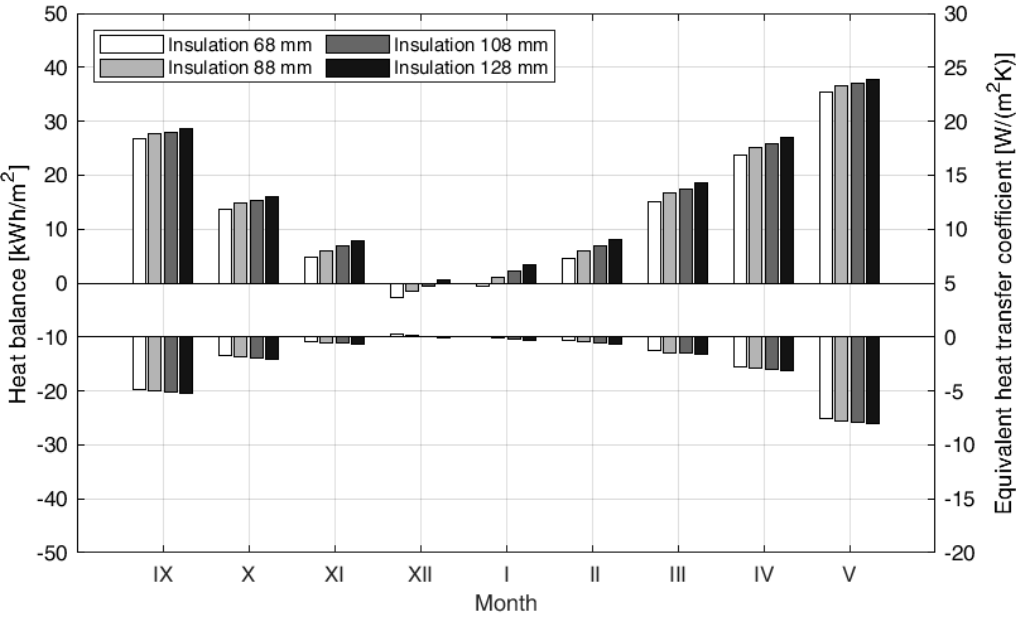
Figure 9. The Q m (upper graph) and U eq (bottom graph) values of the solar wall with transparent Figure 9. The (cid:1843) (cid:3040) (upper graph) and (cid:1847) (cid:3032)(cid:3044) (bottom graph) values of the solar wall with transparent Figure 9. The (cid:1843) (cid:3040) (upper graph) and (cid:1847) (cid:3032)(cid:3044) (bottom graph) values of the solar wall with transparent insulation (SW-TI) for a south orientation in the case of the application of insulation of di ff erent insulation (SW-TI) for a south orientation in the case of the application of insulation of different insulation (SW-TI) for a south orientation in the case of the application of insulation of different thicknesses (location in thicknesses (location in Koszalin). thicknesses (location in Koszalin).